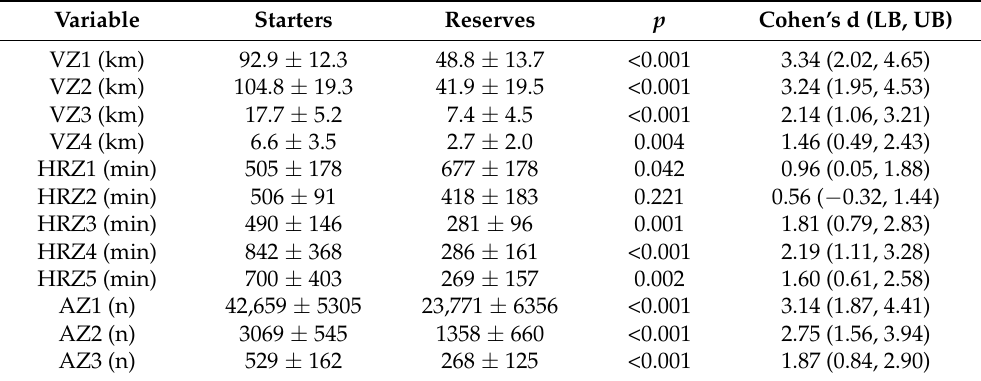
Table 2. Total accumulated match-day workloads in NCAA Division III women’s soccer by starting status (mean ± SD). Variable Starters